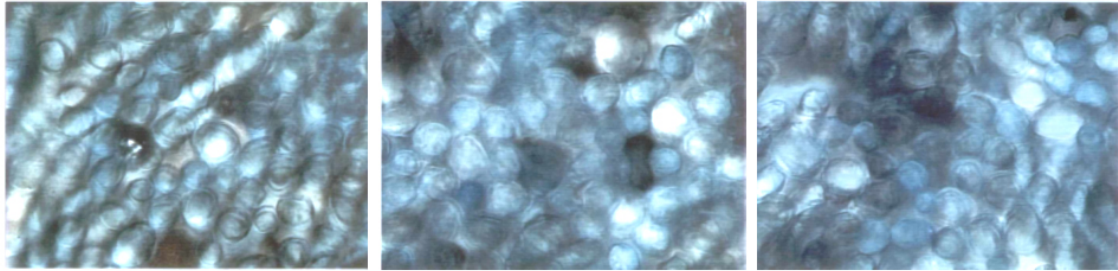
Figure 10. Cross section fibers analysis of wool fibers dyed with Telon Turquoise: a) 98°C without enzyme, b) 85°C without enzyme, c) 85°C with